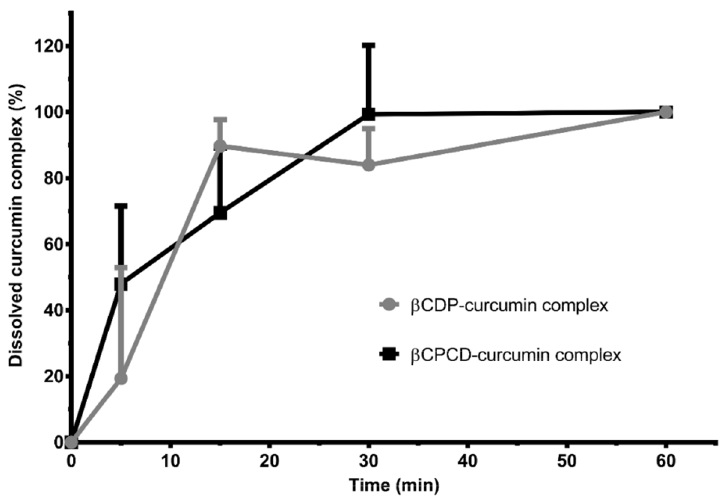
Figure 11. Dissolution curves of hard gelatin capsules filled with curcumin–cyclodextrin polymer complexes (data are presented as means ± SD; n = 3).